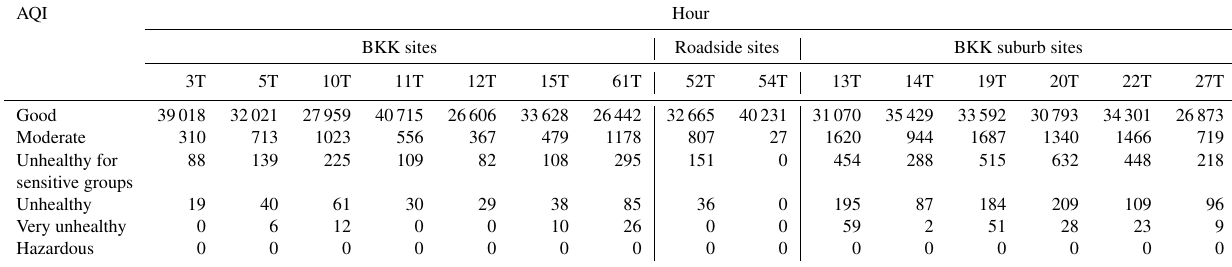
Table 3. Number of hours for the different AQI categories of O 3 over the BMR from 2010 to 2014. AQI